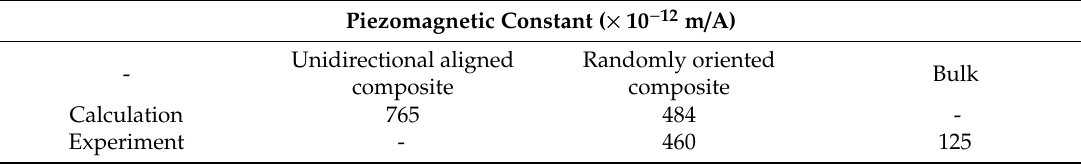
Figure 9. Piezomagnetic constant versus fiber volume fraction of the discontinuous Fe-Co fiber / epoxy composite sheet. Table 2. Calculated and tested piezomagnetic constant of the Fe-Co composite and bulk.